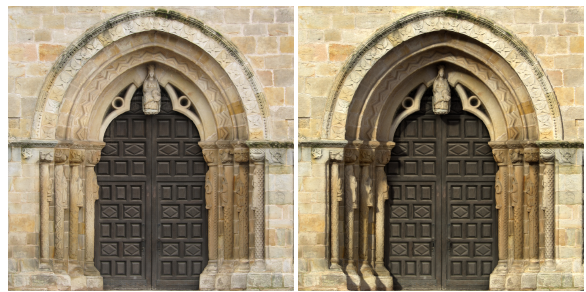
Figure 1: Portada de la Oliva, Asturias, Spain. Orhtoimages of the same object generated from photographs taken either in cloudy conditions (left) or under direct sunlight